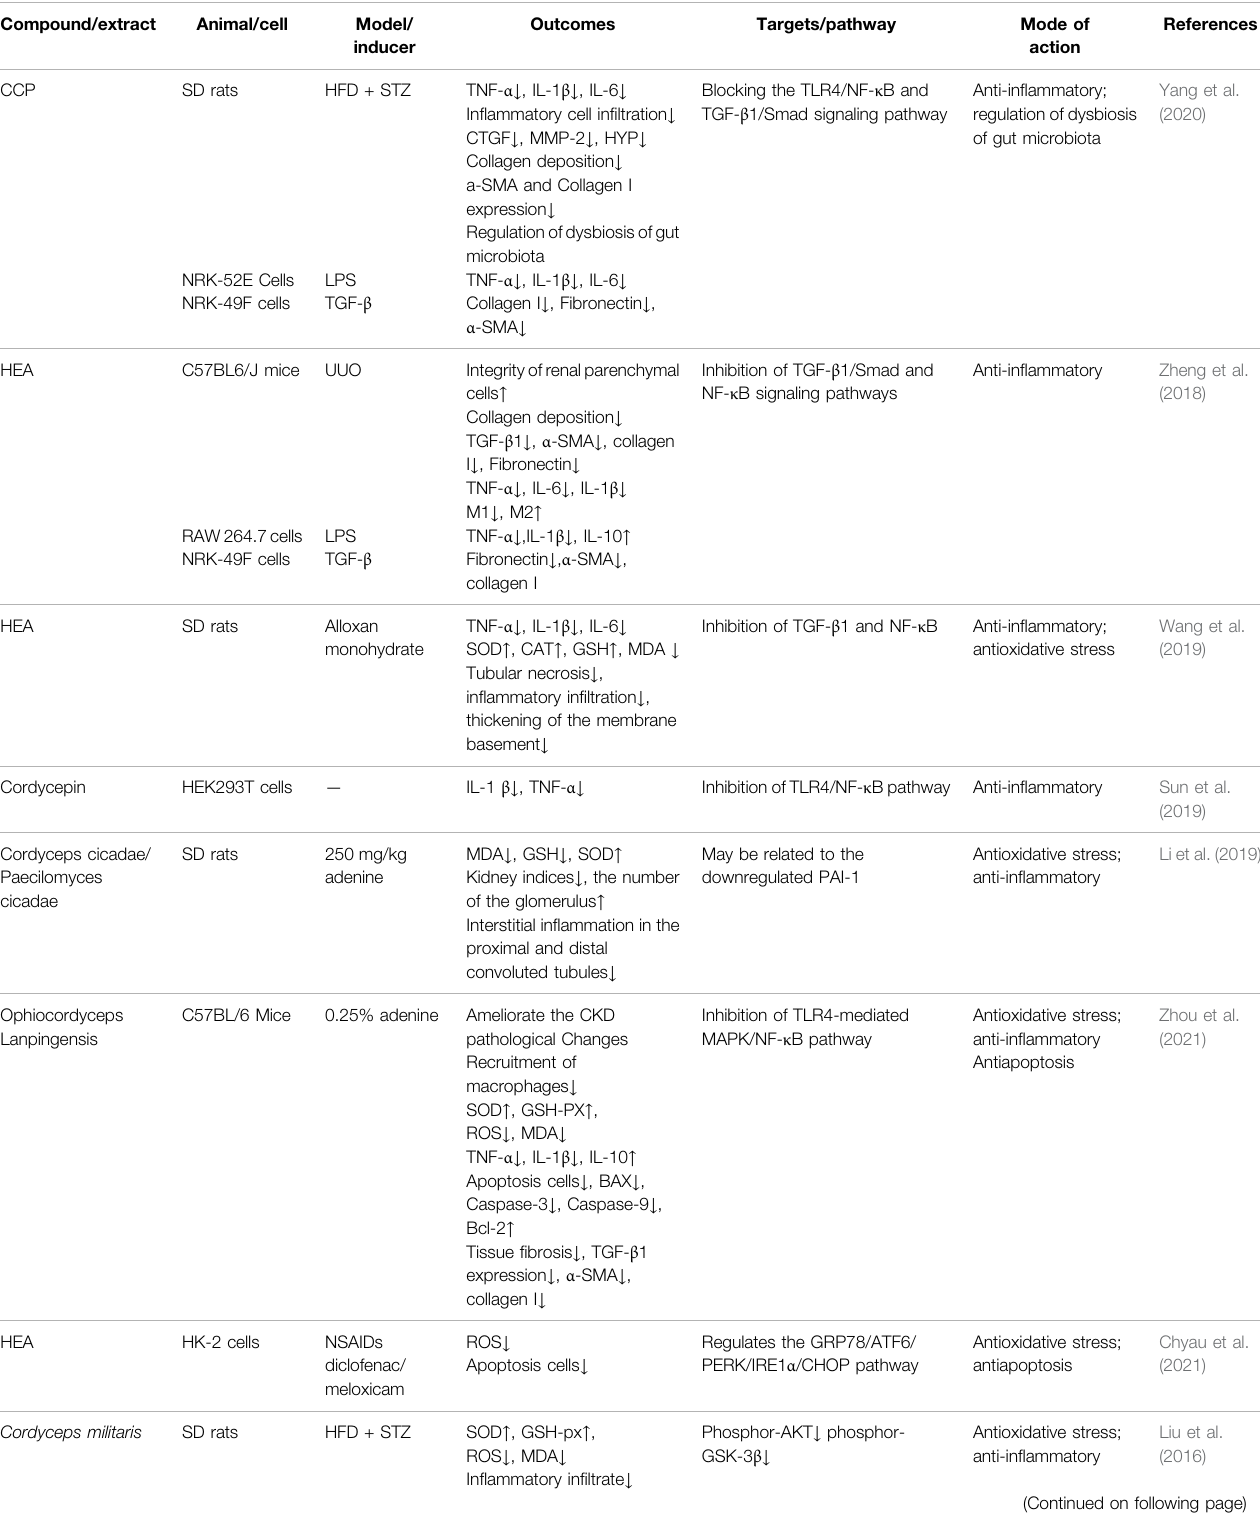
TABLE 1 | Mechanisms of Cordyceps and related products against renal fi brosis.